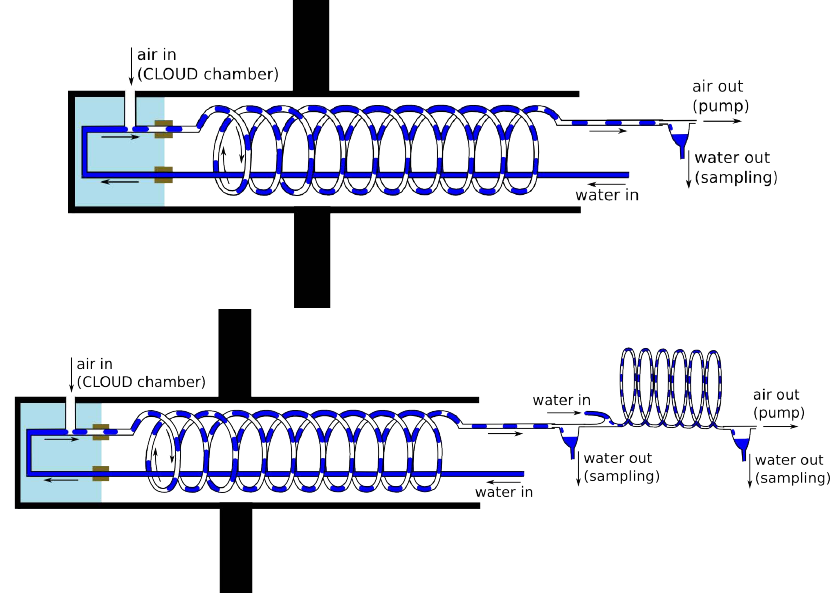
Fig. 1. Unscaled schematic of the sampling system used for CLOUD4 (top panel) and the modified sampling system with two debubblers (bottom panel) for sampling efficiency tests.